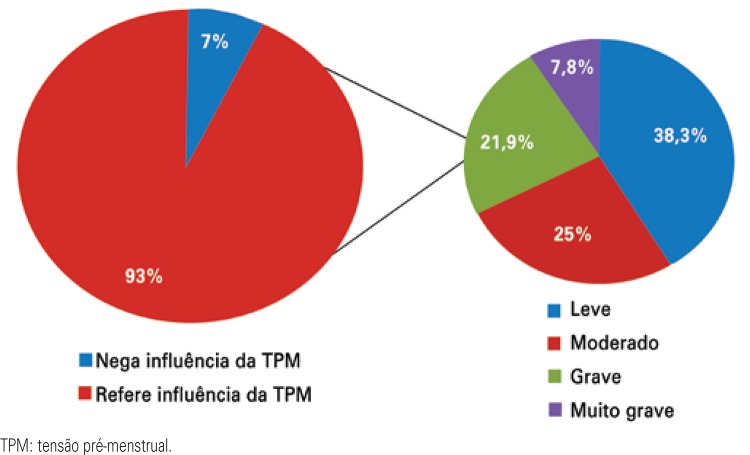
Influência dos sintomas de tensão pré-menstrual sobre o desempenho esportivo